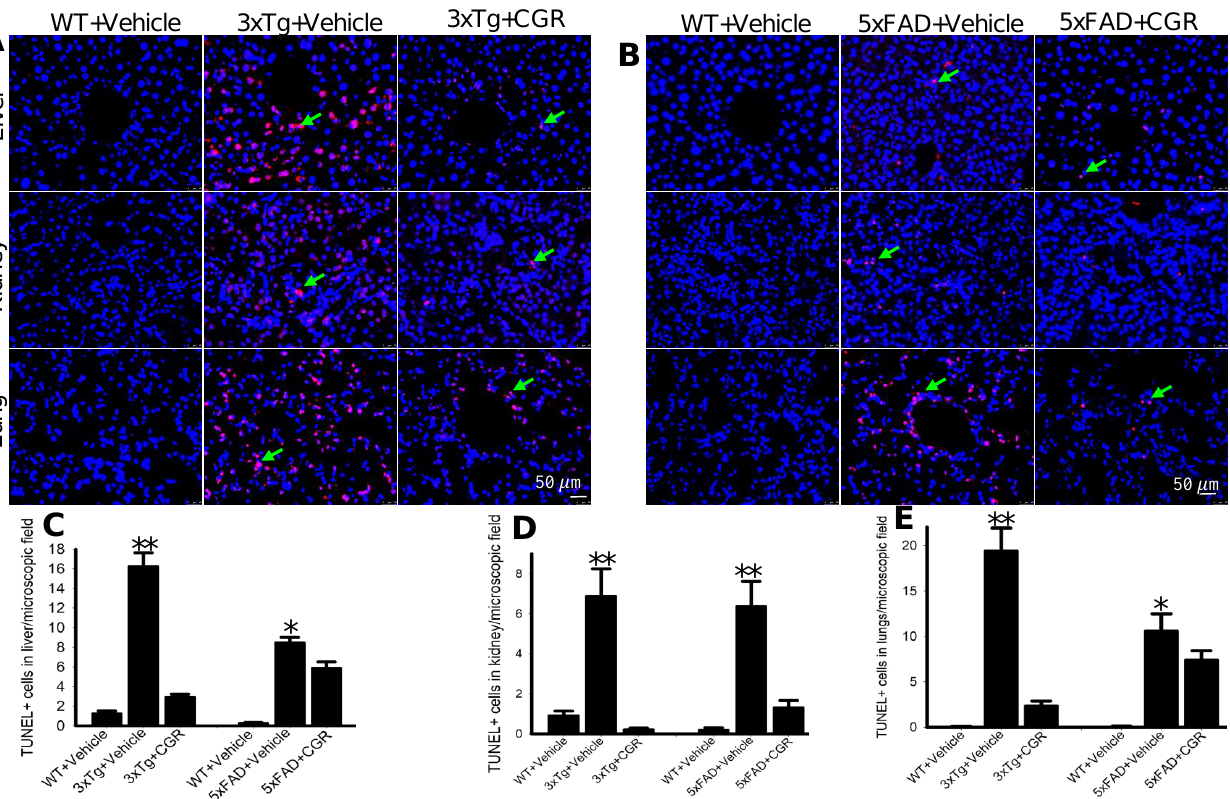
Figure 9. Number of TUNEL-positive cells was decreased in the liver, kidney and lungs by CGR treatment in both 3xTg and 5xFAD mice. After treatment with CGR (100 mg/kg) for 2 months, the WT, 3xTg, and 5xFAD mice were perfused with PBS and fixed with 4% paraformaldehyde and the liver, kidney and lung tissues were collected, embedded with paraffin and sectioned at 5 µ m. The TUNEL assay was performed to detect DNA fragmented cells on these tissues, followed by DAPI, as a counterstain and the images were taken by fluorescent microscope (Leica, Germany) with appropriate excitation/emission filters using 40 × objectives (total magnification = 400 × ). ( A , B ) Representative TUNEL staining photomicrographs of the liver, kidney and lungs from 24- month-old 3xTg mice ( A ) and 18-month-old 5xFAD mice ( B ) after treatment with